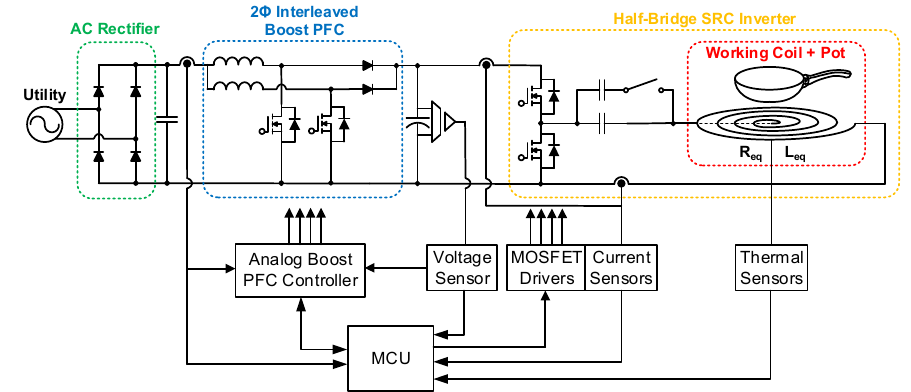
Figure 3. Configuration of the proposed all-metal induction heating (IH) system.